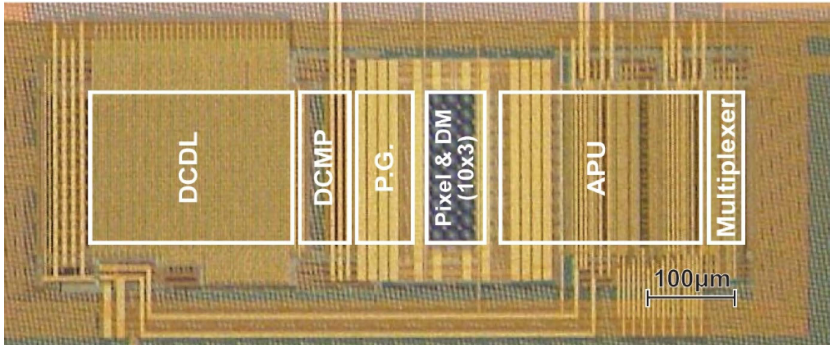
Figure 12. A photomicrograph of the prototype